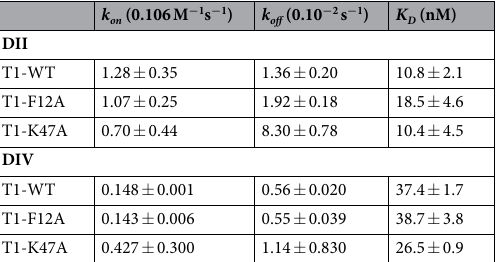
Table 2. Surface plasmon resonance data for direct binding of TIMP-1 mutants to immobilised LRP-1 domains II (DII) and IV (DIV). Data are based on three measurements using five different concentrations for each measurement. The equilibrium constants of dissociation ( K D ) were calculated from the association ( k on ) and dissociation ( k off ) rate constants. Mean values ± standard error are presented.